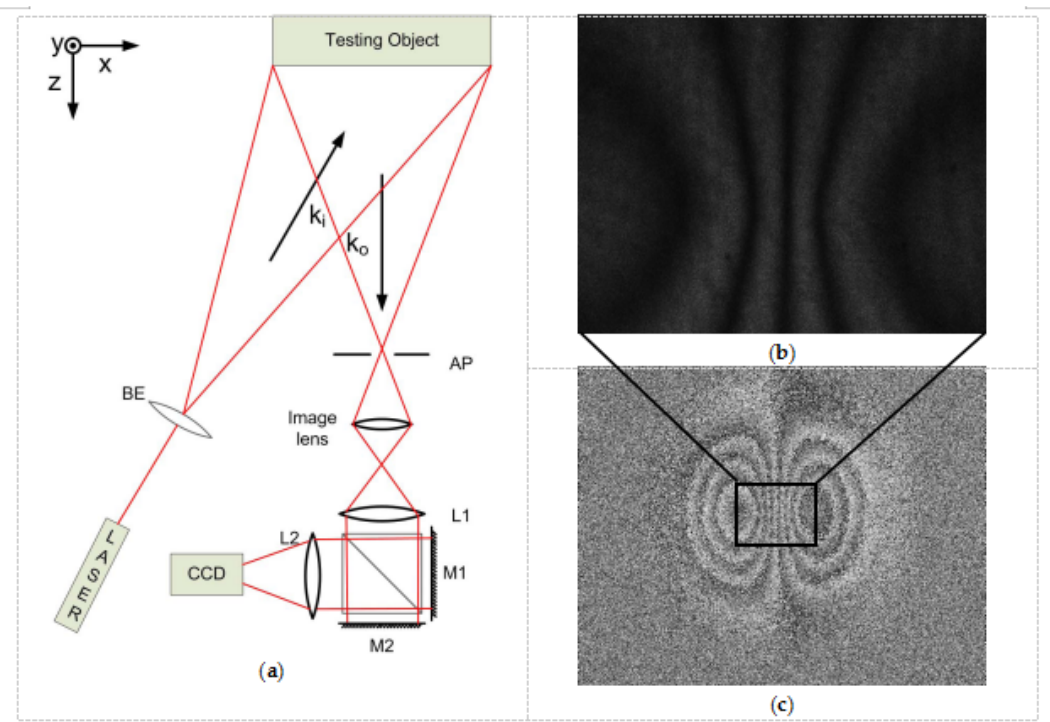
Figure 8. ( a ) The modified Michelson-based SPS-DS system with a 4f system; ( b ) measurement result by traditional shearography system; ( c ) measurement result by modified 4f